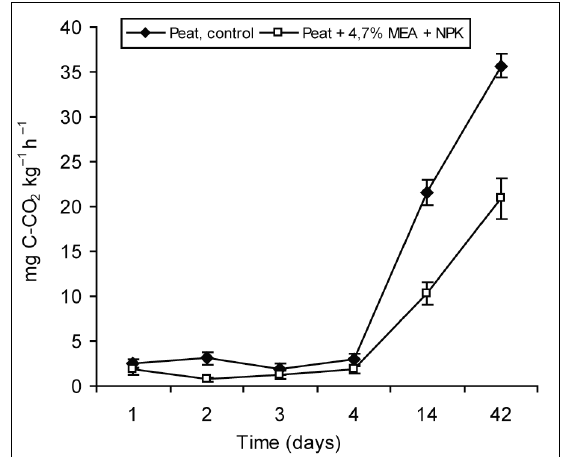
Fig. 5. Respiration rate of the peat (pH 6.3) (control) and